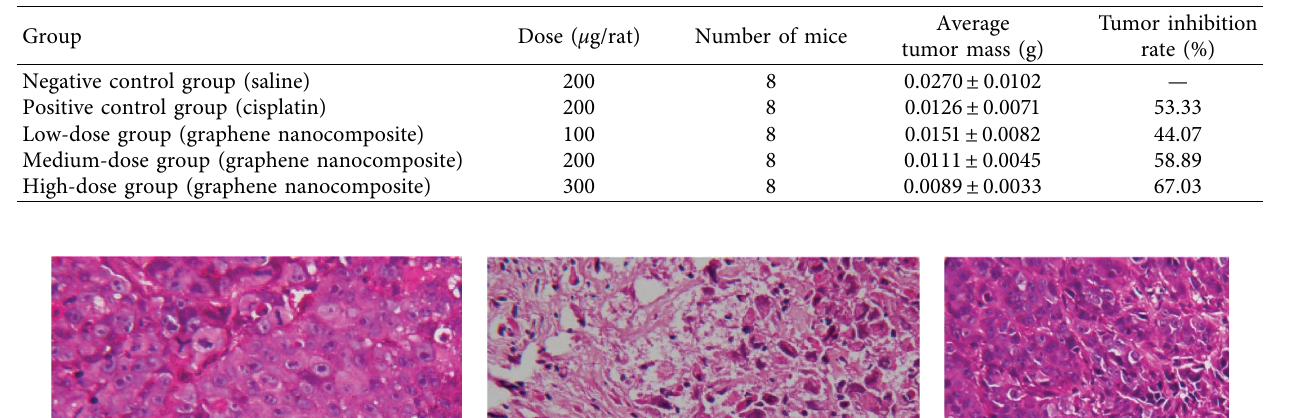
Table 1: Efects of diferent experimental groups on tumor growth.